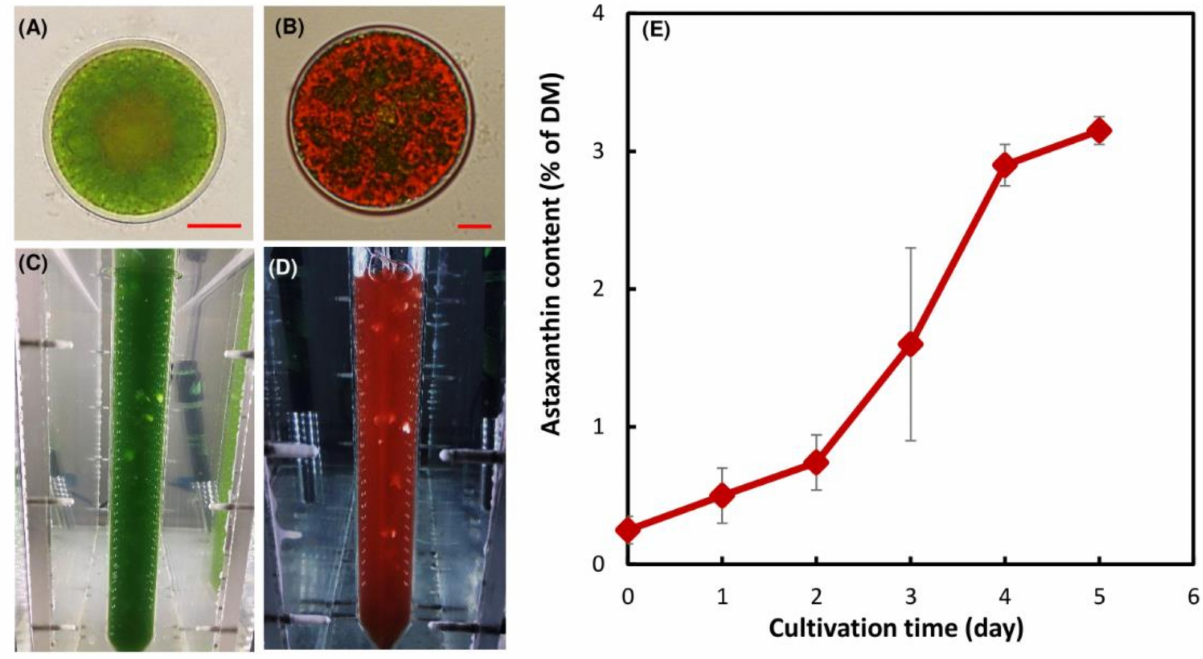
Figure 1. Cells of H. lacustris at the vegetative growth phase ( A ) and at day five of the inductive phase ( B ). Cell suspensions of H. lacustris cultivated in a photobioreactor under autotrophic growth conditions at the vegetative growth phase ( C ) and at day five of the inductive phase ( D ). Carotenoid accumulation in the H. lacustris cells under the stressful conditions; average ± SD ( n = 3) are shown, DM: dry cell mass ( E